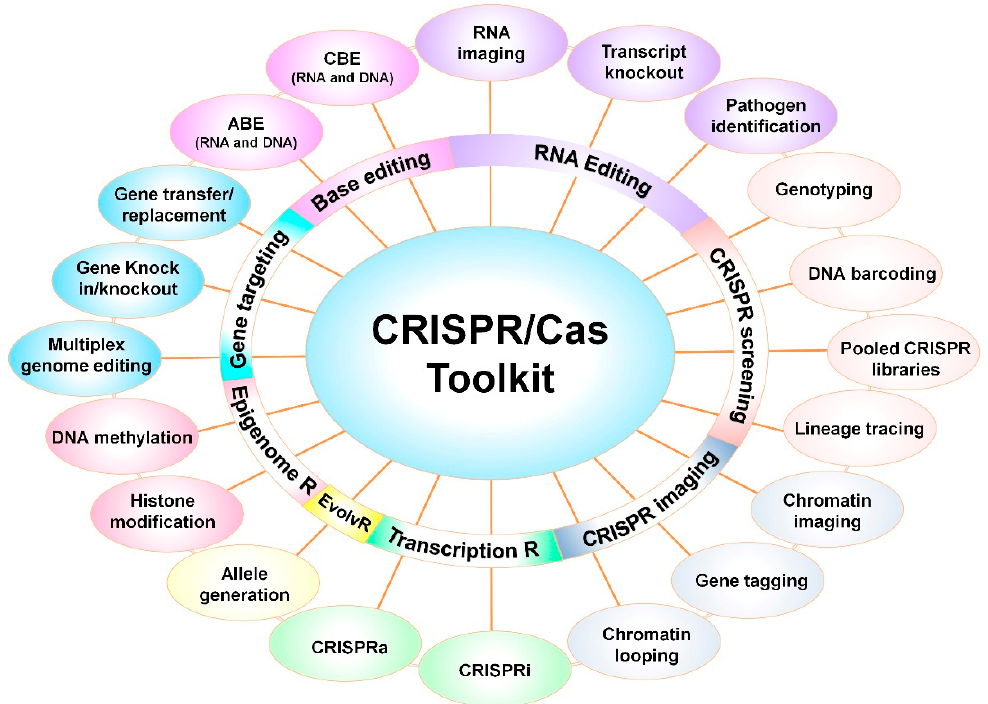
Figure 5. Expanding CRISPR toolkit, including applications beyond genome editing, are shown. The CRISPR-based tools have been designed for various applications in diverse fields. The SpCas9-mediated knock-out or knock-in strategy is most widely implemented in prokaryotes and eukaryotes. Catalytically dead Cas9 (dCas9) or nickase Cas9 (nCas9) and Cas9 orthologs fused with specific modulators have been reprogrammed to perform base editing (ABE, adenine base editor; CBE, cytidine base editor) RNA editing, screening libraries, chromatin imaging, transcription regulation, allele generation using the EvolvR system, and epigenome editing. Further details of each technique discussed in the main text.